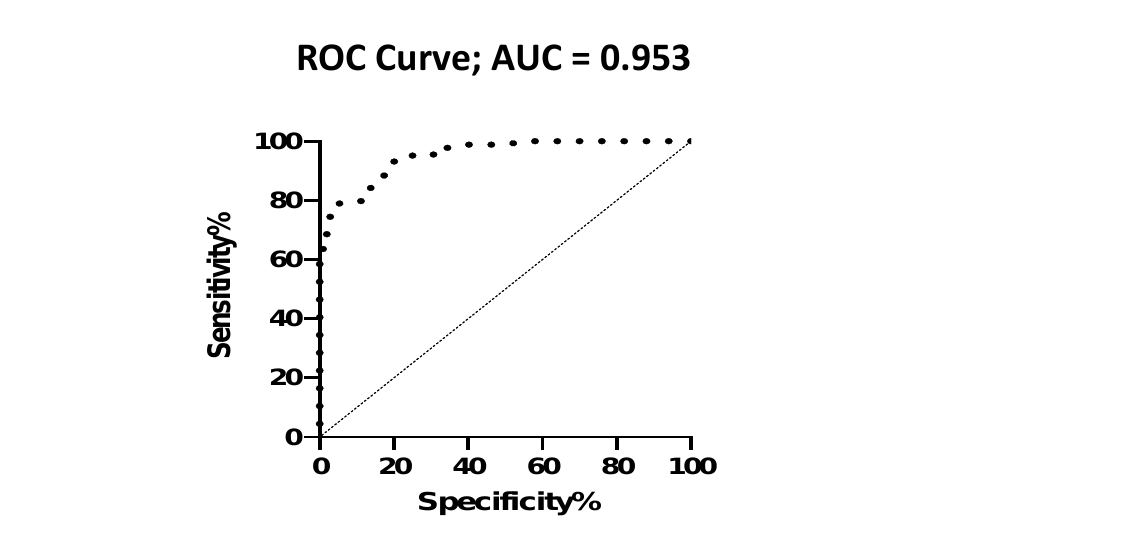
0.786; specificity, 0.951) (Figure 3).